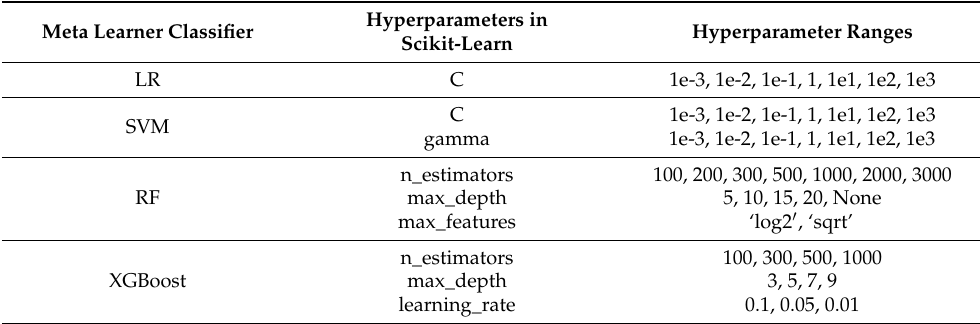
Table 2. Hyperparameters used in meta learners. LR, logistic regression; SVM, support vector machines; RF, random forest.